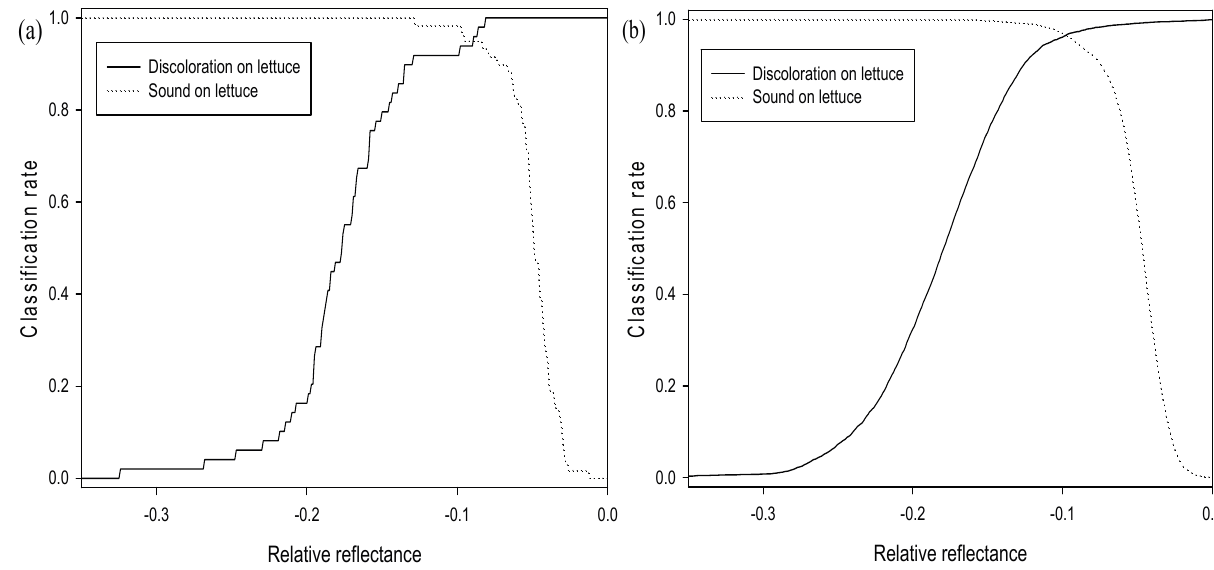
Figure 9. Waveband selection for the subtraction spectra and imaging algorithm. One-way ANOVA results for classifying sound and discolored areas of lettuce using the subtraction of two wavebands in the wavelength range from 400 to 1000 nm.